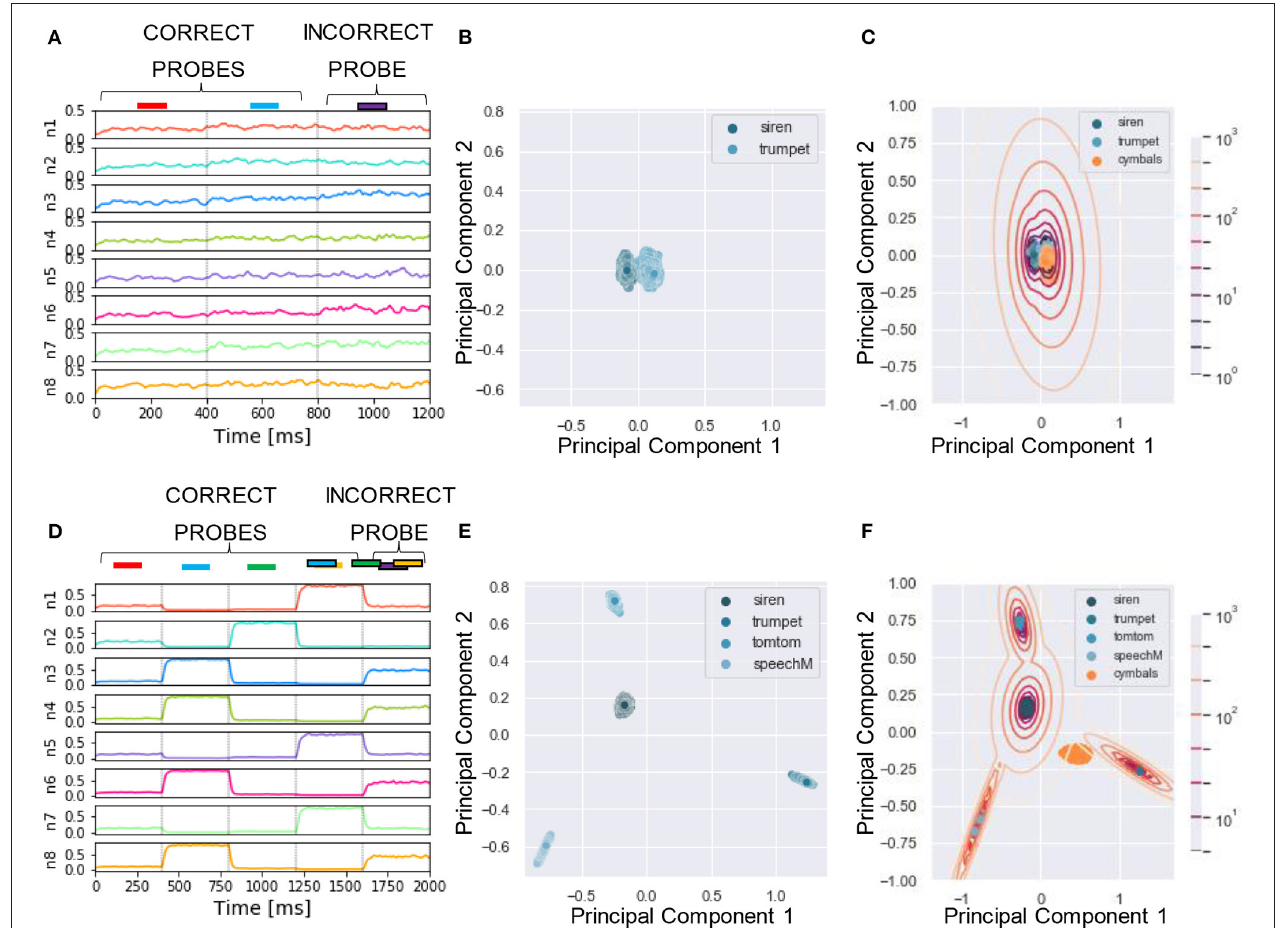
FIGURE 8 | Experiment 4—output dynamics and clustering. (A–C) refer to the results of Experiment 4 on real-world sounds with a single mixture presented during training. (D–F) refer to the results of Experiment 4 on real-world sounds with three mixtures presented during training. (A) Voltage dynamics of the 8 output neurons during inference, when the target, the distractor and one unseen sound are tested. As expected, the neuron population is not able to respond with different dynamics to the three sounds, and the voltage of all the output neurons fluctuates randomly throughout the whole testing sequence. (B) The PCA projection of the datapoints belonging to the target and distractor (in blue) shows that the clusters are collapsed into a single cluster. (C) When GMM is applied, all the datapoints representing both the learnt sounds (in blue) and the unseen sound (in orange) fall within the same regions, making it impossible to distinguish the different sounds based on the population dynamics. (D) Voltage dynamics of the 8 output neurons during inference, when the target, the three distractors, and one unseen sound are tested. As expected, the neuron population has learnt the feature of the different sounds and responds with different dynamics to the five sounds. Each output neuron has an enhanced response to one or few sounds. (E) The PCA projection of the datapoints belonging to the four correct probes (in blue) shows that the clusters are more compact and more spatially distant one from the other with respect to the result obtained with the synthetized sounds. (F) When GMM is applied, the model shows that the network clearly distinguished the learnt sounds (in blue) from the unseen sound (in orange). These results show that the grouping cues improve the model accuracy with respect to the synthesized